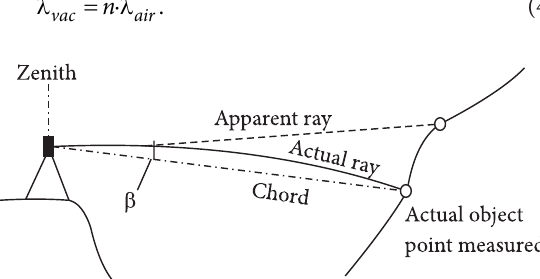
Figure 4. The actual ray is refracted, whereas the chord is the straight line (Friedli et al.,